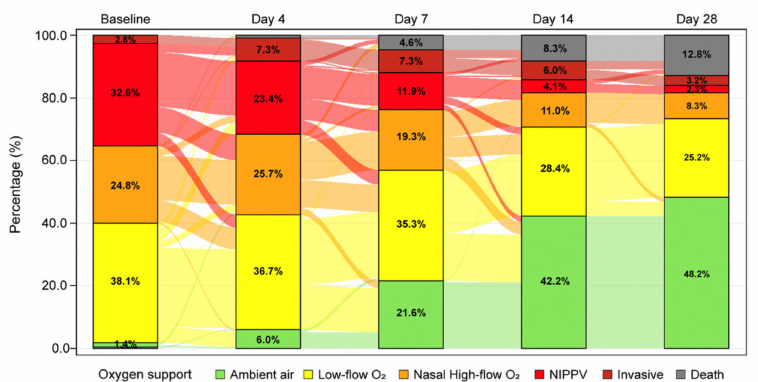
Figure 2. Sankey diagram of oxygen support status. The “last observation carried forward” method was used for the missing data. Patients with “yes”indicated in both ventilation type and intubation were considered as “invasive”. One patient had missing information on oxygen support at baseline. The diagram shows the percentages in each class considering 218 evaluable patients. NIPPV—non- invasive positive-pressure